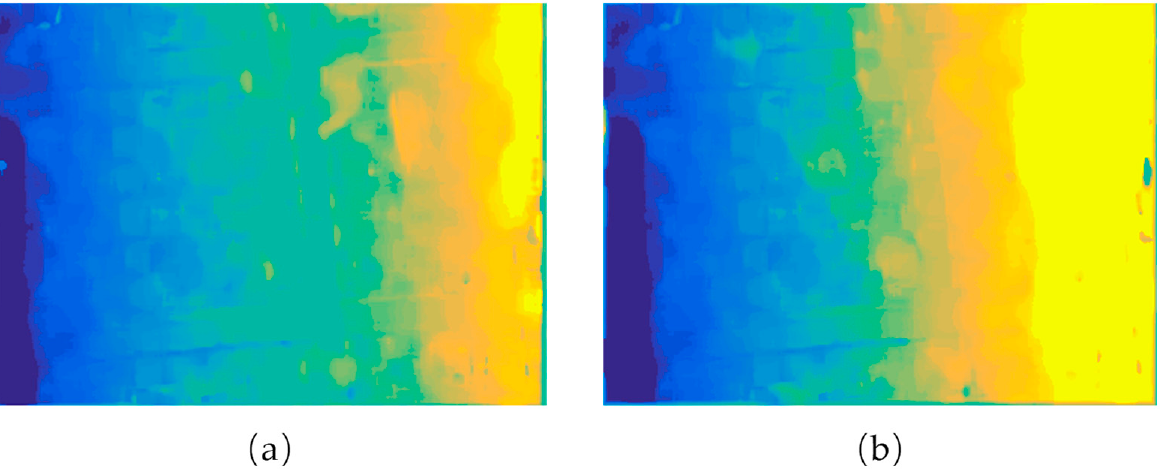
Figure 6. Estimation of the depth map of the gradient scene: ( a ) geometric constraint method; ( b ) MRF method.